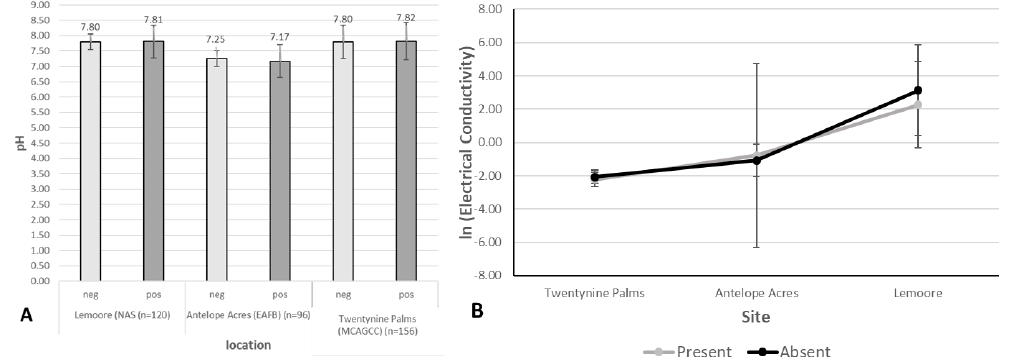
Figure 8. ( A ) Soil pH averages for Coccidioides DNA-positive samples (dark grey) and Coccidioides DNA-negative samples (light grey) from all the three locations (averages, error bars are based on 95% confidence). ( B ) Ln (Electrical Conductivity) by site and presence of Coccidioides DNA. Twentynine Palms: Coccidioides DNA present n = 10, Coccidioides DNA absent n = 8. Antelope Acres: Coccidioides DNA present n = 3, Coccidioides DNA absent n = 6. Lemoore: Coccidioides DNA present n = 3, Coccidioides DNA absent n = 3.